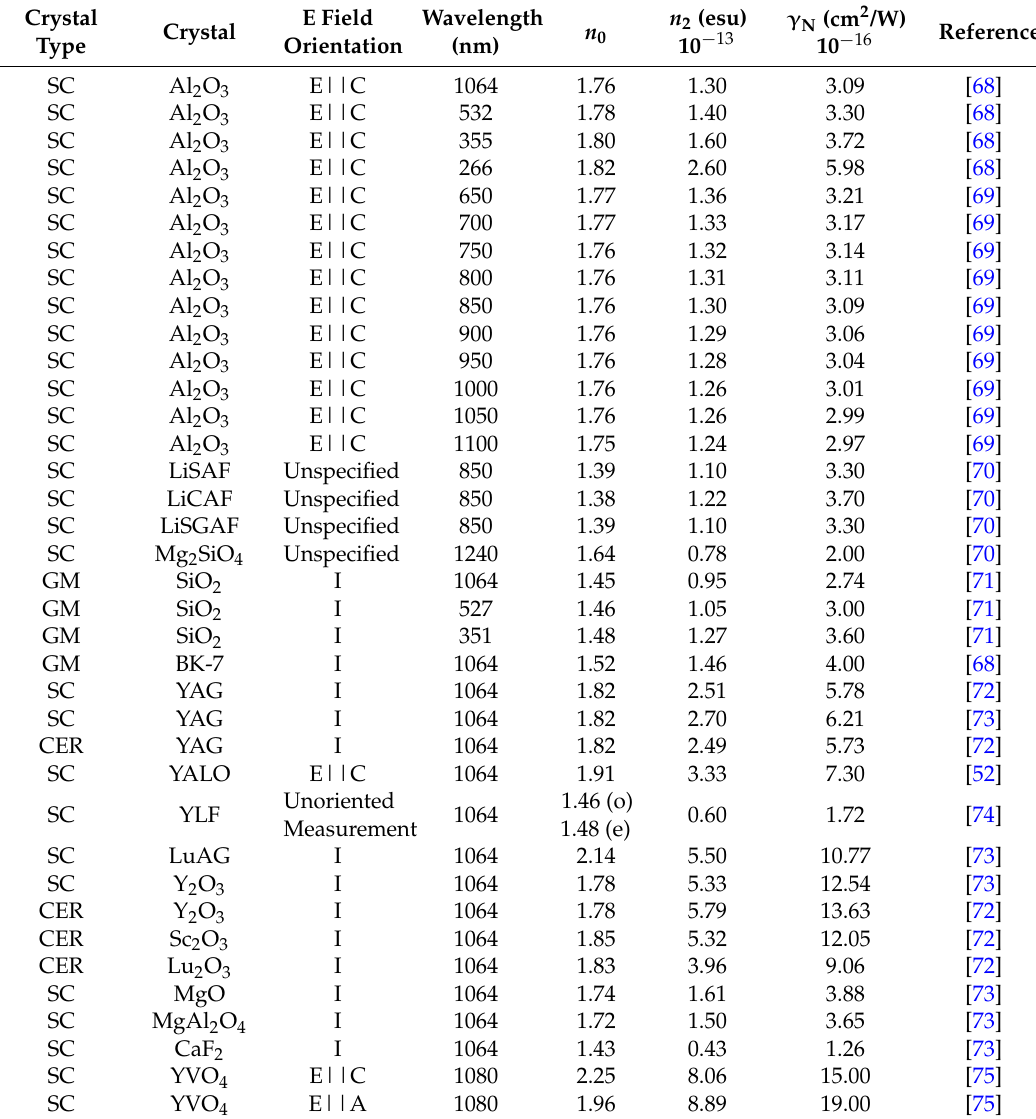
Table 4. Reported room temperature values of the linear index, nonlinear index and nonlinear coefficient for a number of important laser crystals and optical materials. Also shown are the crystal type (SC-Single Crystal, GM-glassy material, or CER-Ceramic), the E-field orientation (Parallel to specified crystal axis, unspecified, and I-Isotropic), and the measurement